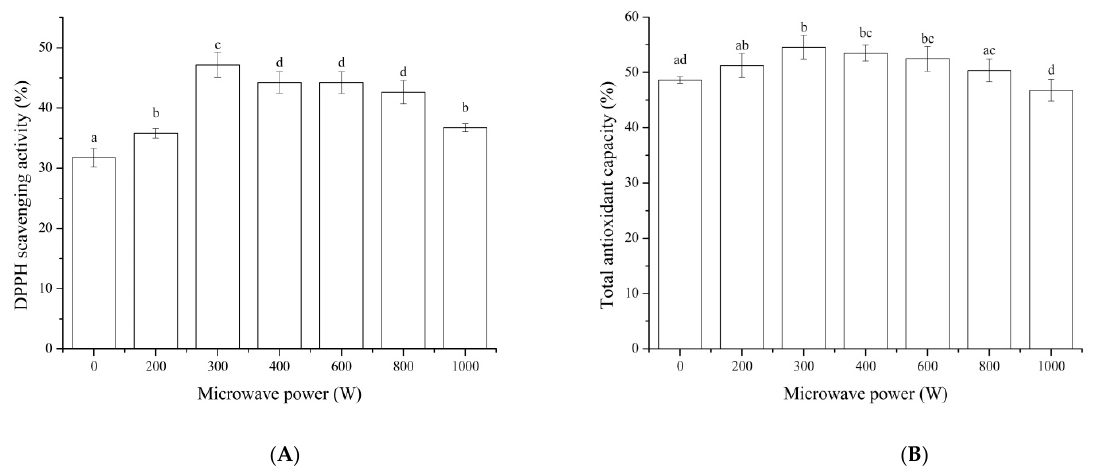
Figure 4. The effect of digestion in vitro on DPPH scavenging activity ( A ) and total antioxidant capacity ( B ) of MP hydrolysate after pretreated by microwave. Results represent the means of three determinations±standard deviation. Means with different superscripts (a, b, c, d) are significantly different ( p < 0.05).